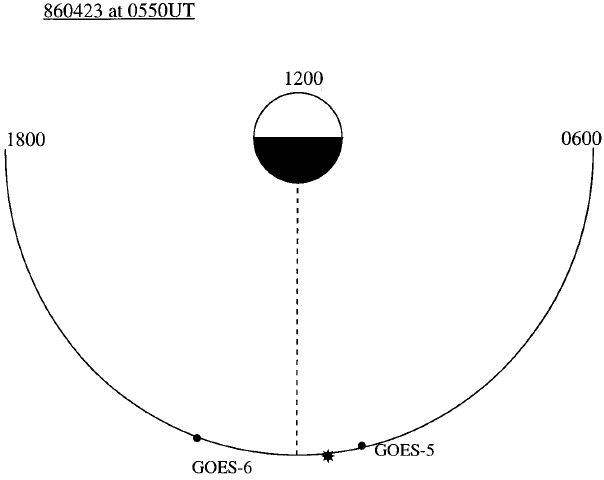
Fig. 4. The position of GOES-5 and GOES-6 satellites is given in a local time versus radial distance representation for the April 23, 1986 event, at 0550UT when the AL onset is detected. The * point indicates the possible location of the sector of the initial SCW formation